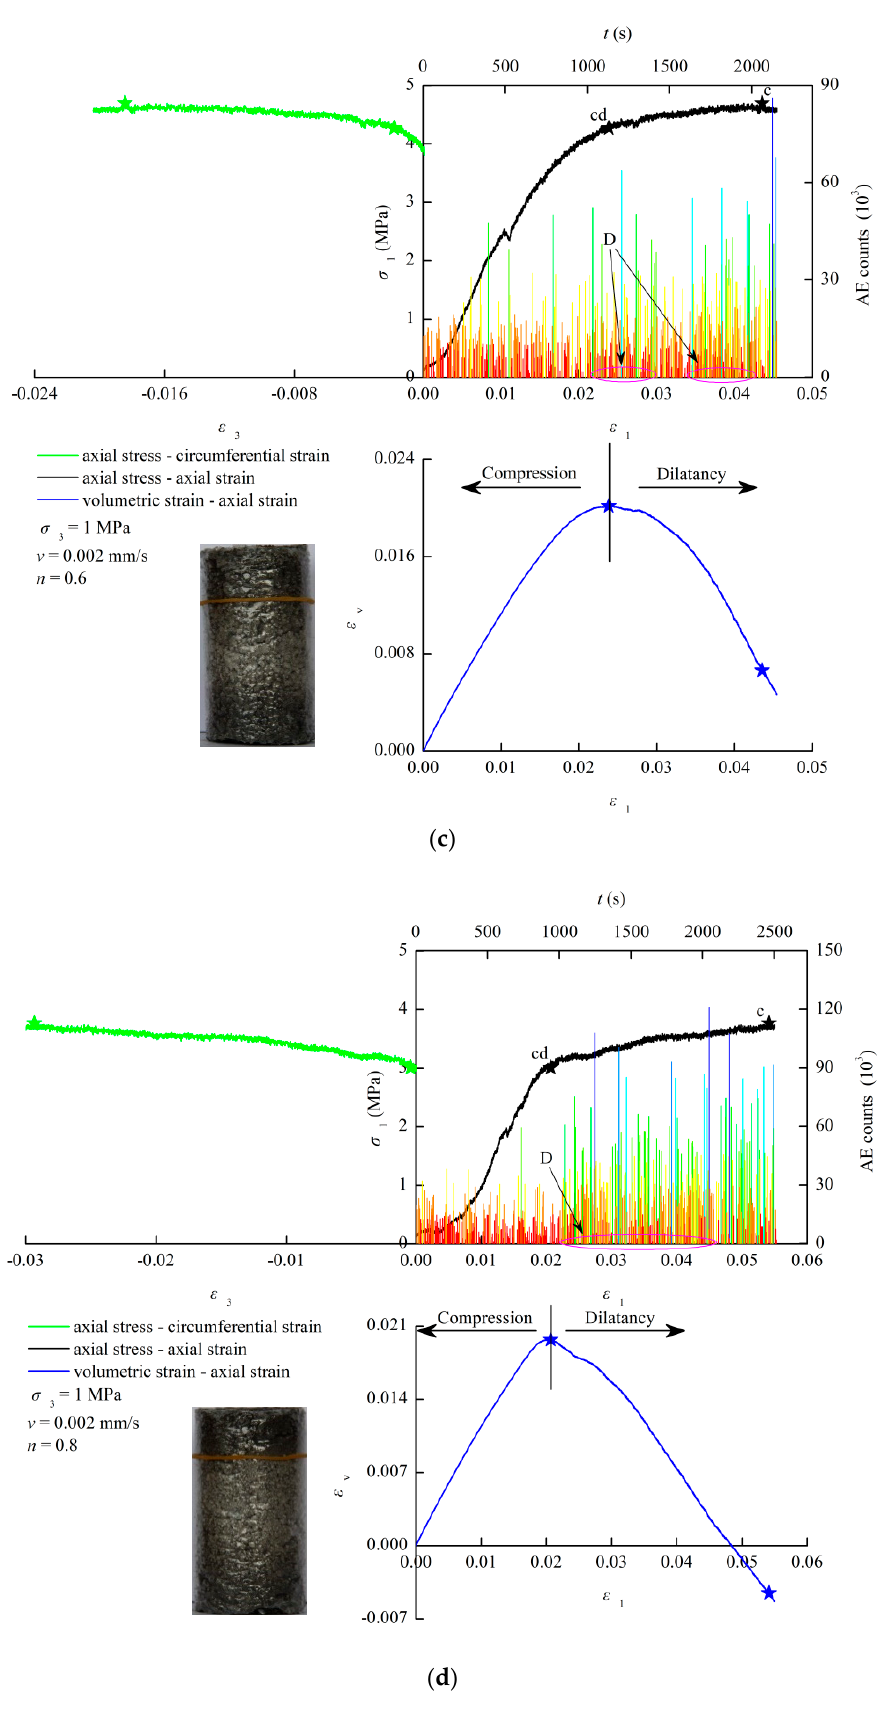
Figure 7. Stress–strain-AE curves of CPB specimens with different Talbot indices of particles: n = 0.2 ( a ); n = 0.4 ( b ); n = 0.6 ( c ); n = 0.8 ( d ).